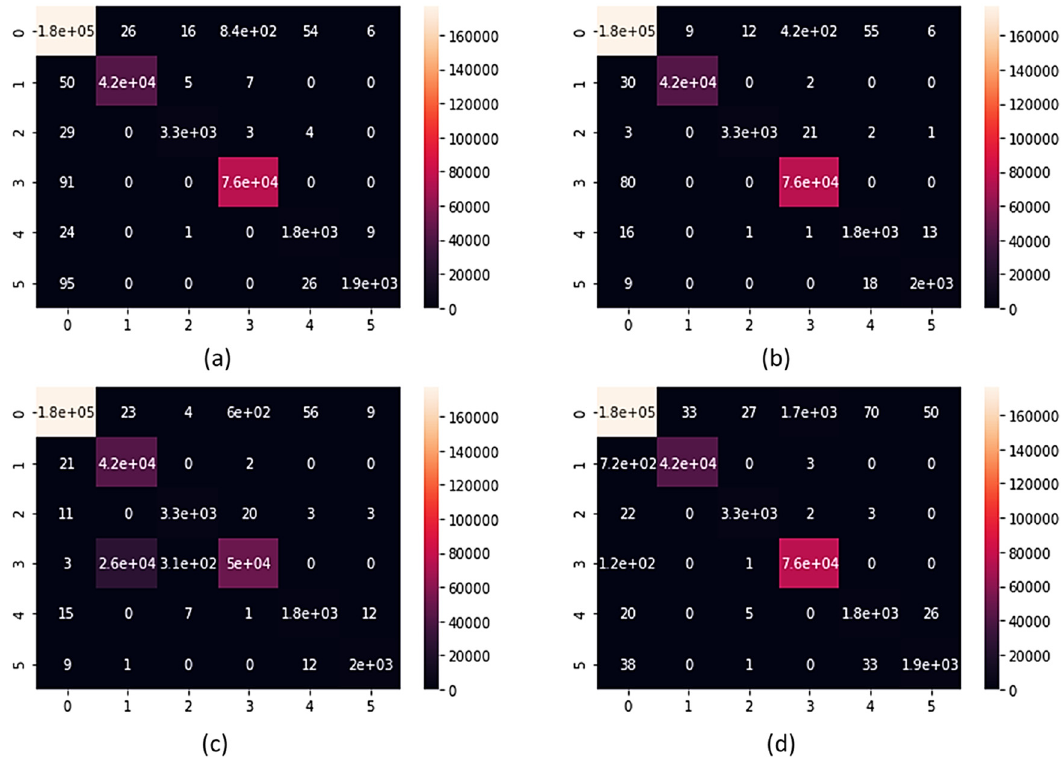
Figure 10: The confusion matrixes of the four deep learning models. ( a ) The RNN heatmap. ( b ) The CNN - BiLSTM heatmap. ( c ) The LSTM heatmap. ( d ) The CNN